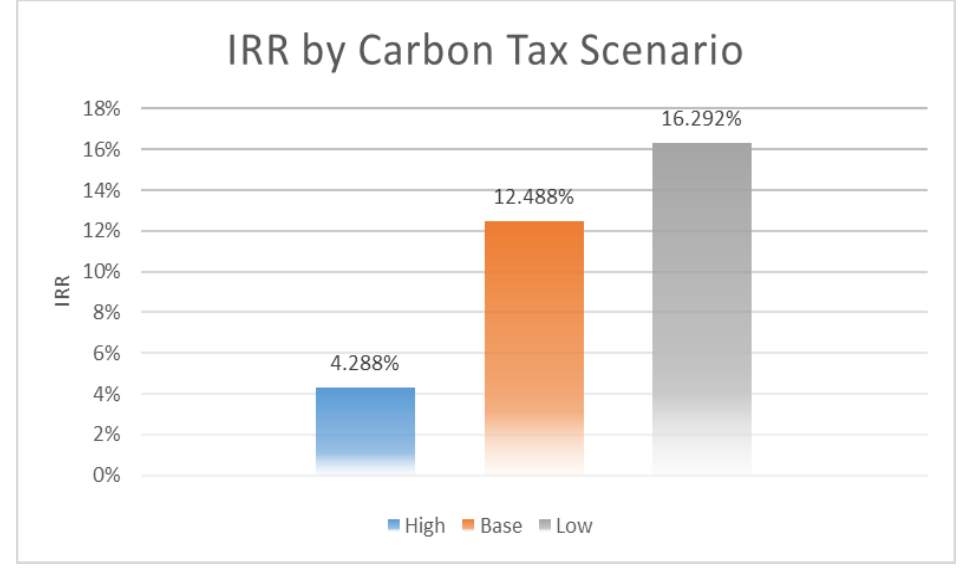
Figure 11. IRR by carbon tax scenario (Electricity tariff is 0.09 $/kwh).